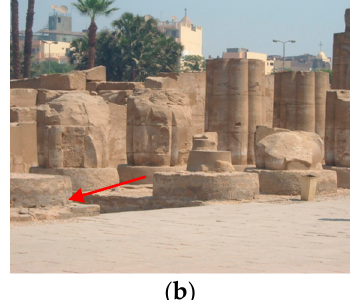
Figure 9. Deterioration in the walls of Luxor temple ( a , b ).